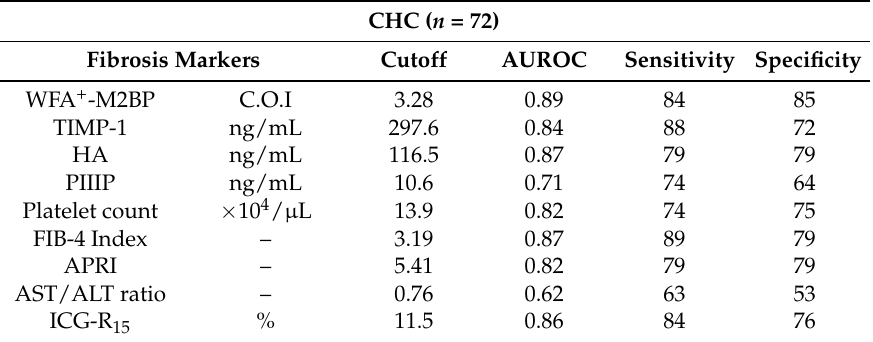
Table 2. The cutoff value and diagnostic ability of each fibrosis marker in CHC